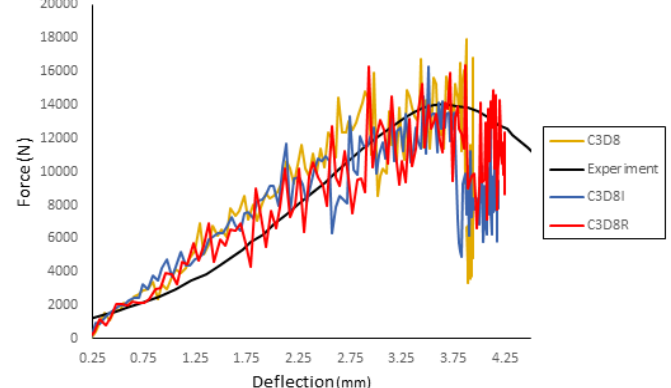
Figure 11. Comparison between element types for the cortical bone and sutures.